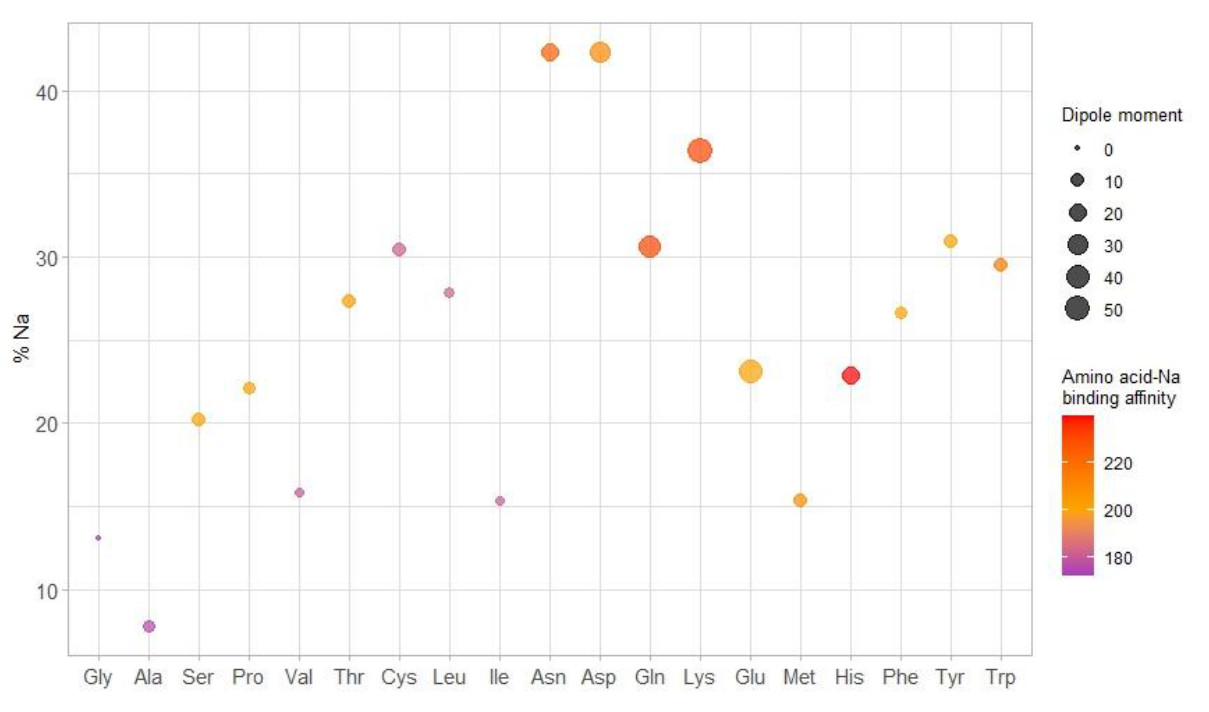
Figure 4. Percentage of sodium-amino acid adduct formation. Amino acids are listed by increasing molecular mass; dots are colored depending on the binding affinity between Na and the amino acid and the dimension increases with increasing dipole moment. Generally, some positive correlations between the molecular weight and the %Na were highlighted for non-polar amino acids (Gly, Ser, Pro, Thr and Cys or Ala, Val and Leu) for the same dipole moment and for Met, His, Phe and Tyr for the same binding affinity. Outliers amino acids are also present, putatively due to the arrangement of the characteristic chemical groups in the side chain.